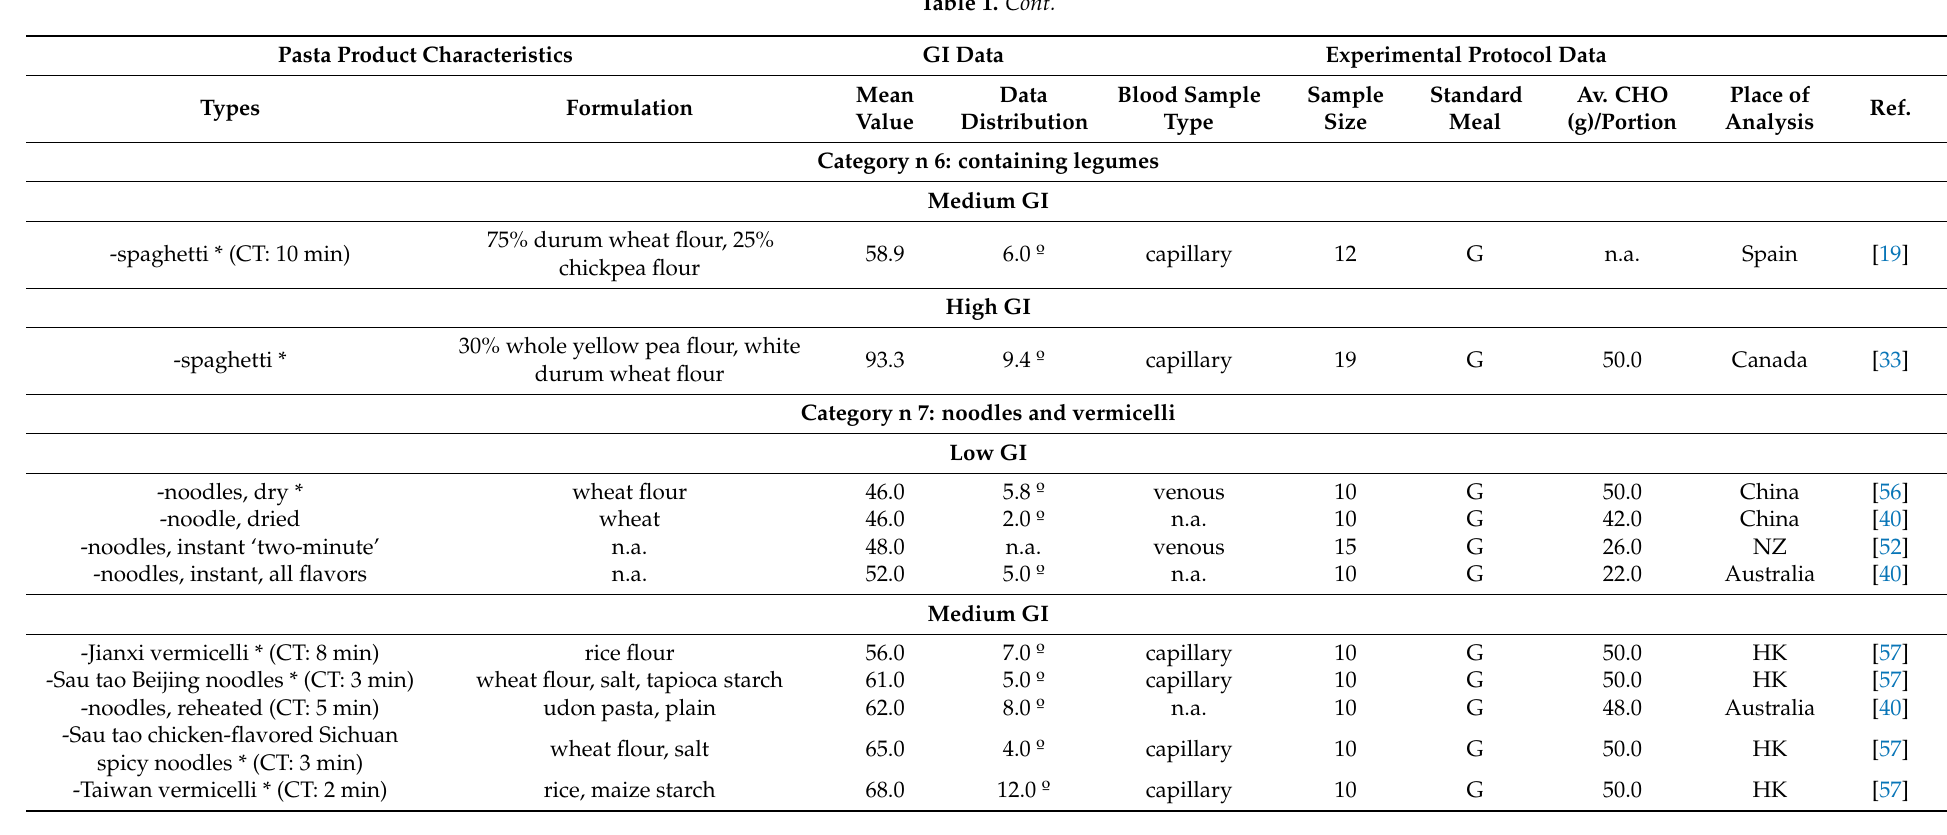
Table 1. Pasta product characteristics, glycemic index and experimental protocol data.